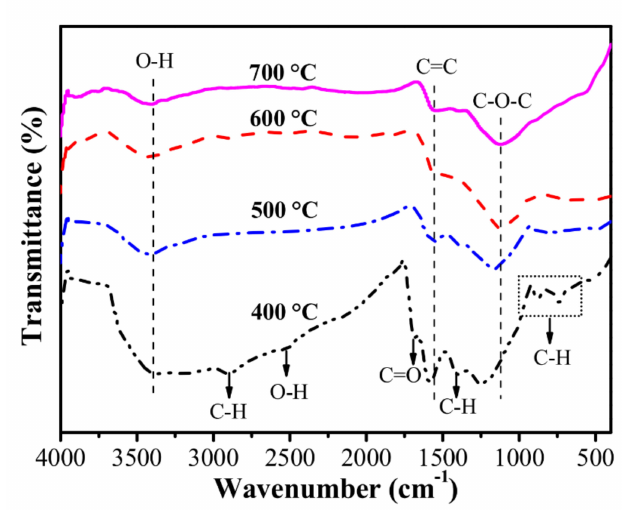
Figure 6. FTIR spectra for activated carbon samples obtained at di ff erent pyrolysis temperatures (reprinted from [44] with the permission of Elsevier,